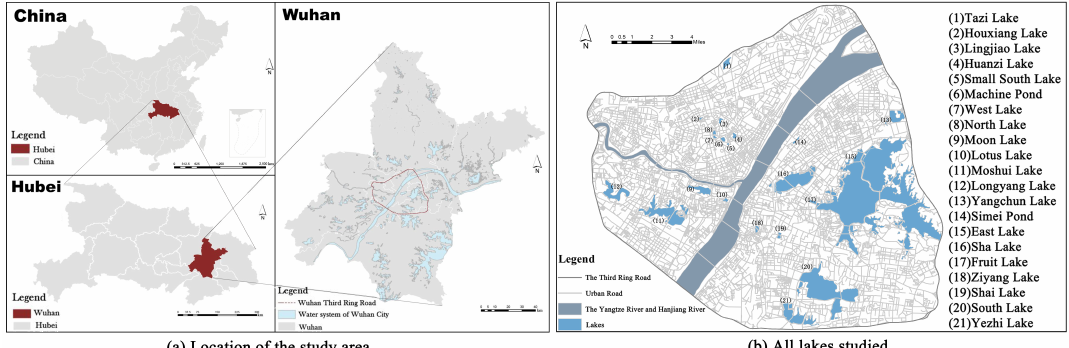
Figure 1. Location of Wuhan and all lakes